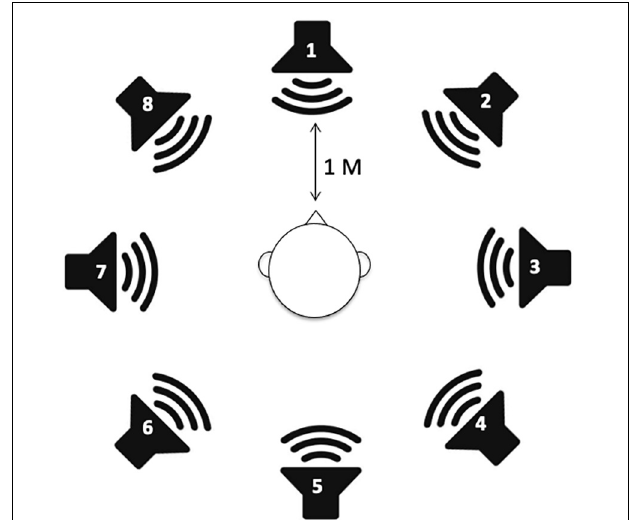
FIGURE 1 | Speaker setup for sound localization measurements. A total of eight speakers are positioned in a full circle with 45 ◦ angular